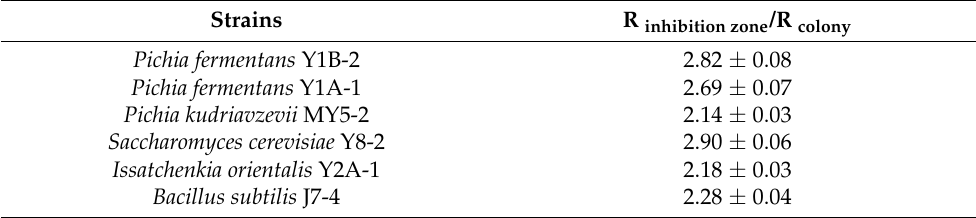
Figure 1. The sketch map of the antibacterial experiment results. Table 1. The R inhibition zone/R colony values of the six